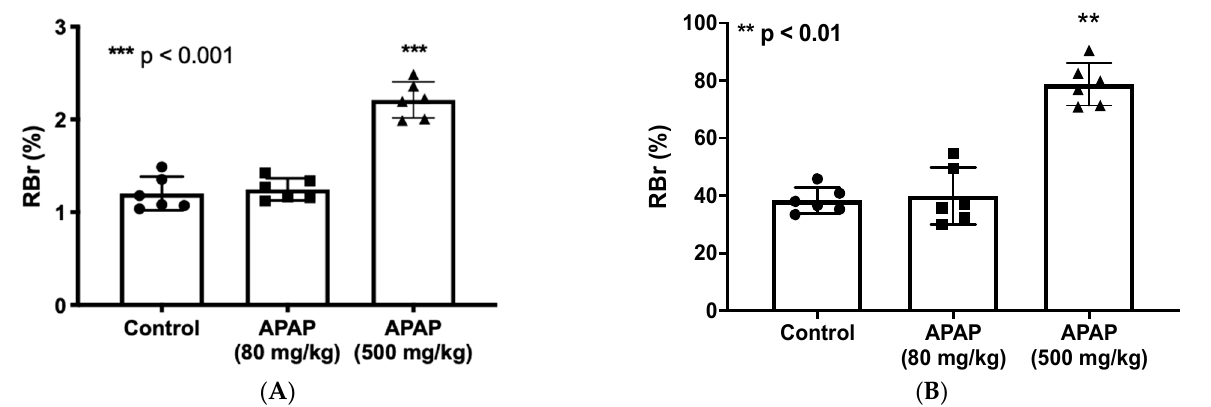
Figure 1. BBB paracellular permeability to sucrose and codeine is increased at three hours follow- ing high-dose APAP administration. ( A ): In situ brain perfusion with [ 14 C]sucrose as a vascular paracellular permeability marker shows significantly elevated radioactivity level represented in brain-to-perfusate radioactivity ratios (RBr %) in brains of high-dose APAP-treated rats ( n = 6) in comparison to vehicle or low-dose APAP-treated rats. No significant change radioactivity level was measured in the low-dose APAP (80 mg/kg) treated rats. ( B ): In situ perfusion with [ 3 H]codeine following APAP injection shows significantly higher radioactivity represented in brain-to- perfusate radioactivity ratios (RBr %) in brains of APAP (500 mg/kg)-treated rats ( n = 6) in compar- ison to vehicle. Data are expressed as mean ± S.D. (** p < 0.01; *** p < 0.001).